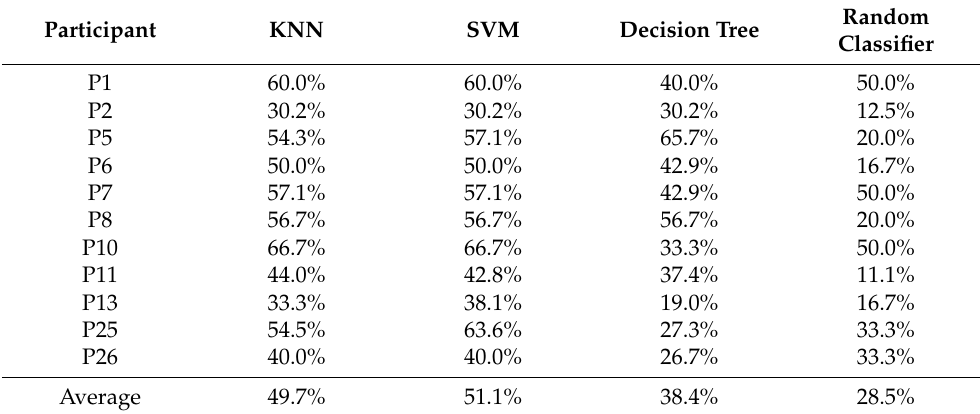
Table 3. Classification accuracies achieved by the DBM-based classification with ML validation for every participant (P1–P26). The second to fourth columns are the average accuracies for the DBM classification with KNN, SVM and decision tree validation, respectively. The last row includes the accuracies that would have been achieved by a random